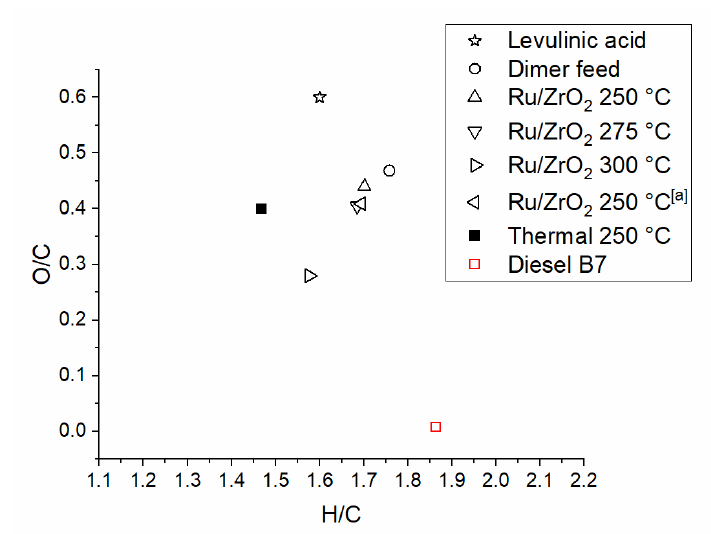
Figure 6. van Krevelen diagram of the molar H / C and O / C ratios of the dimer feed and the organic liquid product mixtures compared to levulinic acid and standard diesel [29]. [a] τ b = 1.1 g cat h g feed−1 .